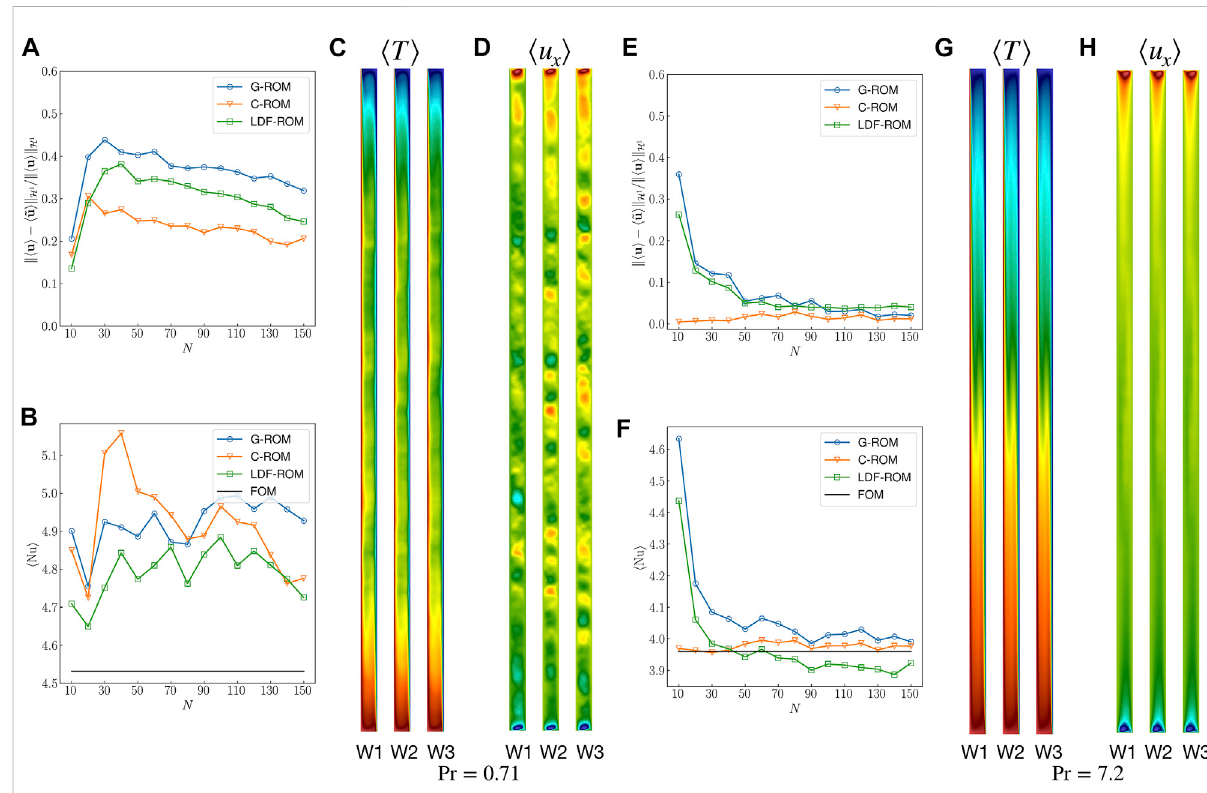
FIGURE 11 ROMperformancecomparisonbetweenPr =0.71andPr=7.2atRa=3×10 5 and θ g =90 ° . (A – D) Behavioroftherelative H 1